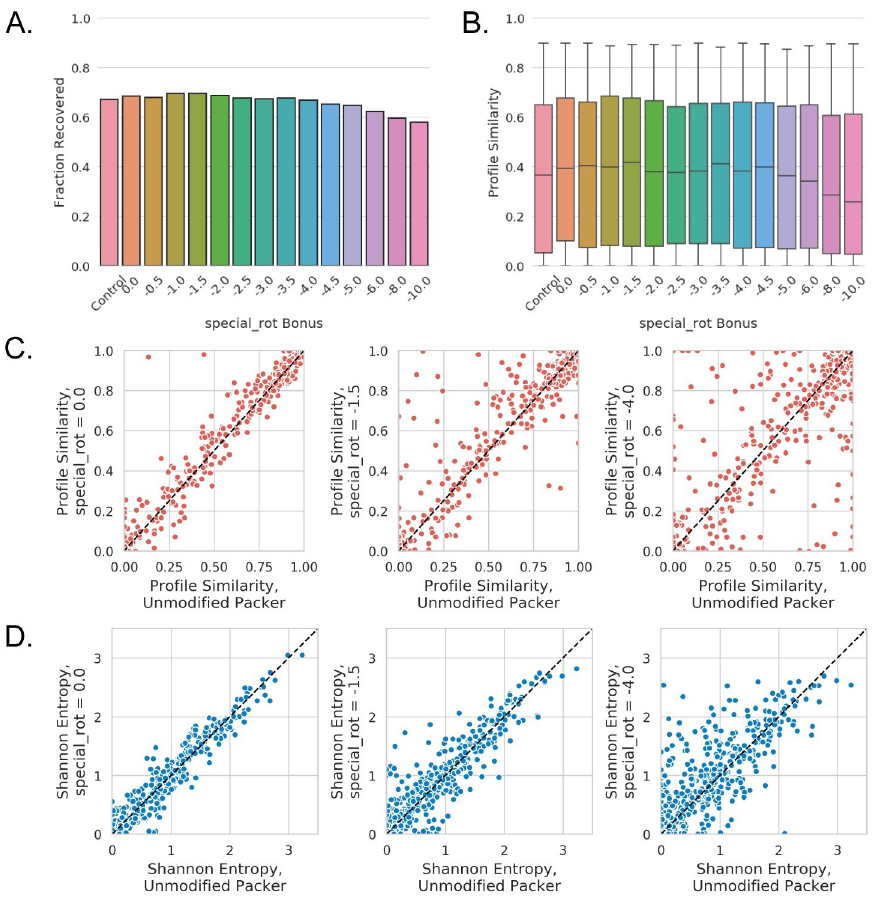
Fig 4. Complementary Rotamers Improve Binding Site Sequence Recovery. A. The fraction of designable positions in the benchmark complex set where the correct (wild-type) residue identity was incorporated at least 50% of the time (native sequence recovery) for a range of special_rot bonus values. Control indicates native sequence recovery when using the unmodified Packer. B. Box and whisker plots for profile similarities at designable positions in the benchmark set, where designable positions that achieve a profile similarity of > 0.9 regardless of modifications to the Packer have been removed (plots with all positions are shown in S2 Fig). Box and whiskers denote quartiles, where whiskers indicate minimum and maximum values, boxes indicate 25 th and 75 th percentiles, respectively, and the line indicates the median value. C. Scatter plots showing profile similarity for individual designable positions at various special_rot bonus values (left: 0; middle: -1.5; right: -4.0) compared to the unmodified Packer. D. Scatter plots showing shannon entropy for individual designable positions at various special_rot bonus values (left: 0; middle: -1.5; right: -4.0) compared to the unmodified